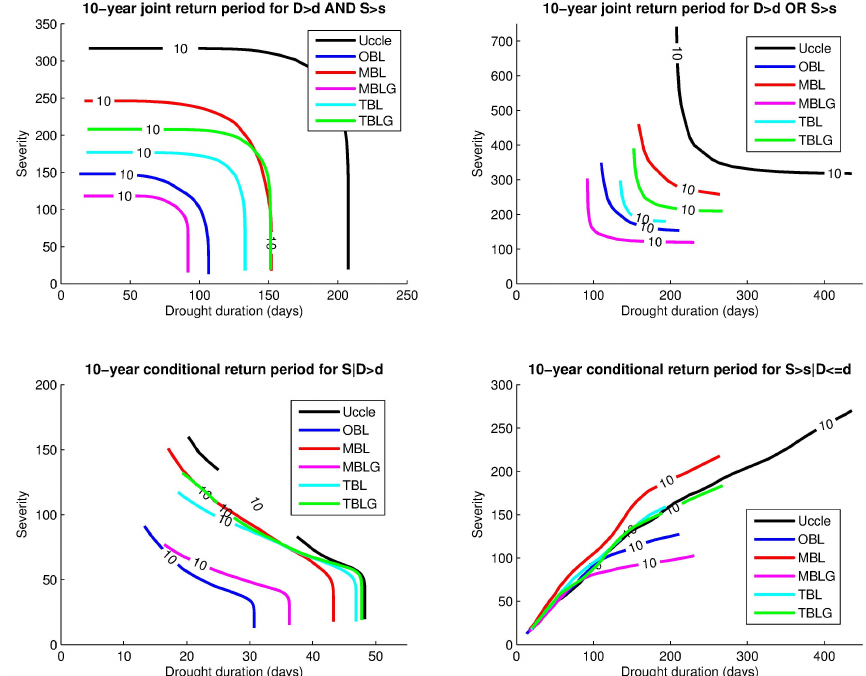
Fig. 10. 10yr return period for droughts simulated by Uccle (black), OBL (blue), MBL (red), MBLG (pink), TBL (cyan) and TBLG (green) with { D ≥ d AND S ≥ s } (left, above panel); { D ≥ d OR S ≥ s } (right, above panel); { S | D >d } (left, below panel); and { S >s | D ≤ d } (right, below